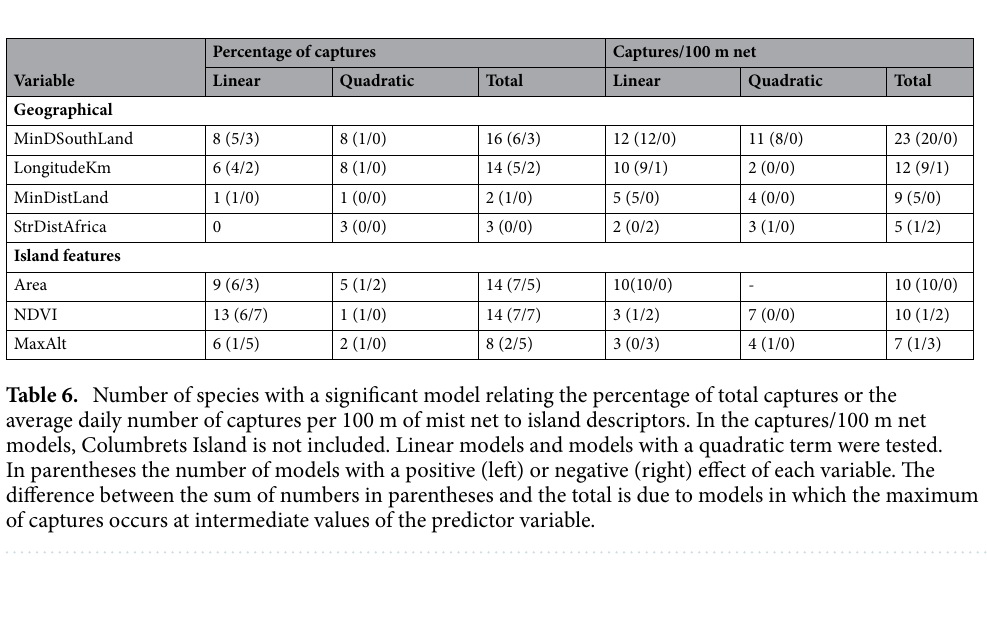
Percentage of captures Captures/100 m net Variable Linear Quadratic Total Linear Quadratic